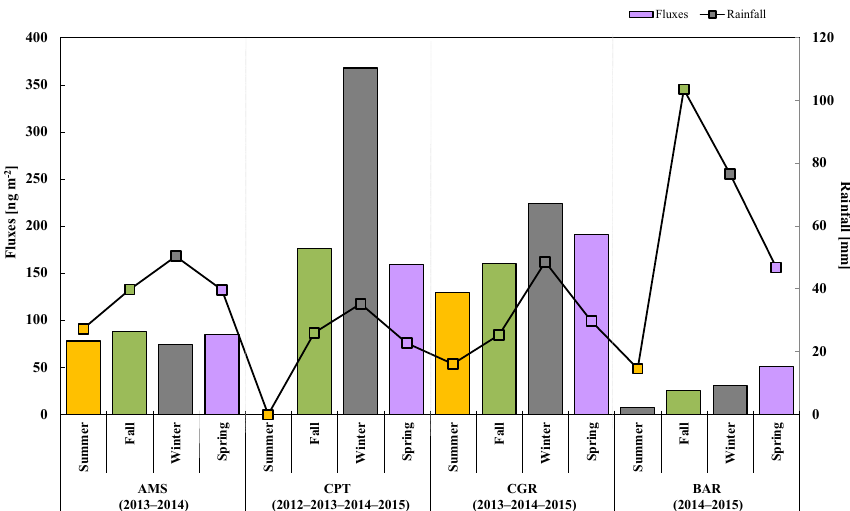
Figure 14. Seasonal mean values distribution of sampling-weighted (by 15-day reference) fluxes and rainfall at the four GMOS sites in the Southern Hemisphere from 2012 to